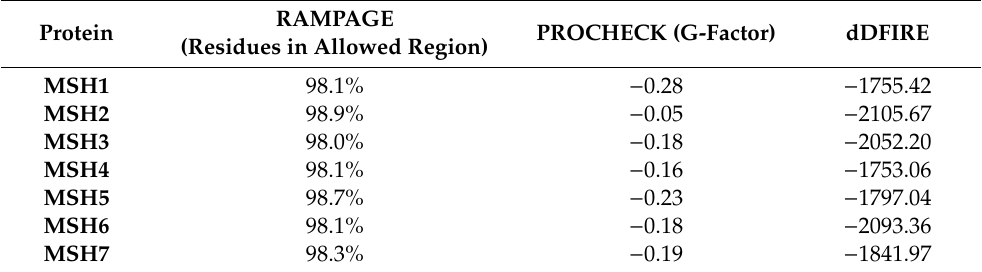
Table 2. 3D structure prediction verification tools of MSH proteins.